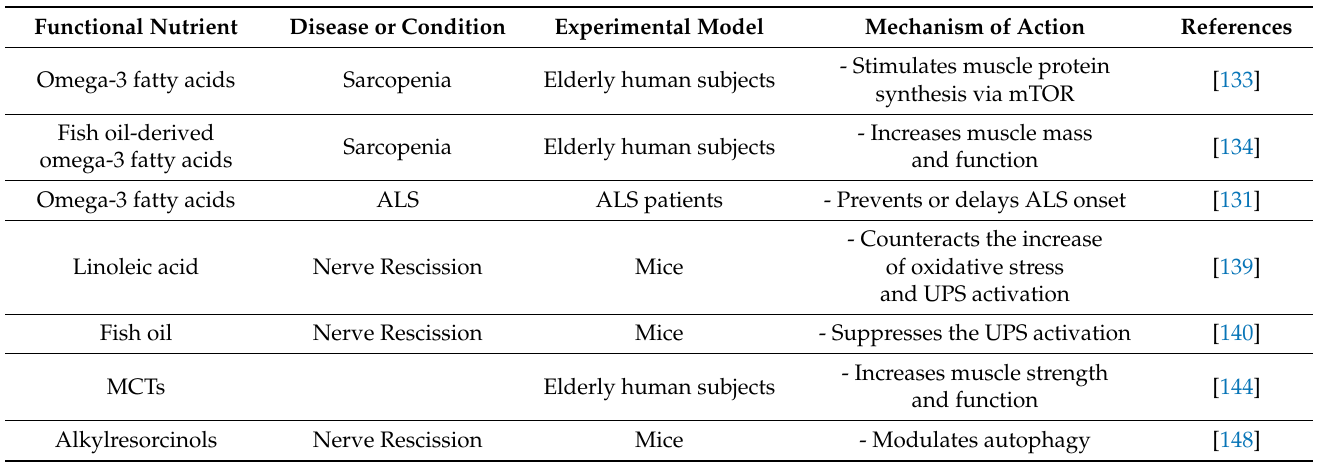
Table 2. Lipids effective in counteracting neurogenic muscle